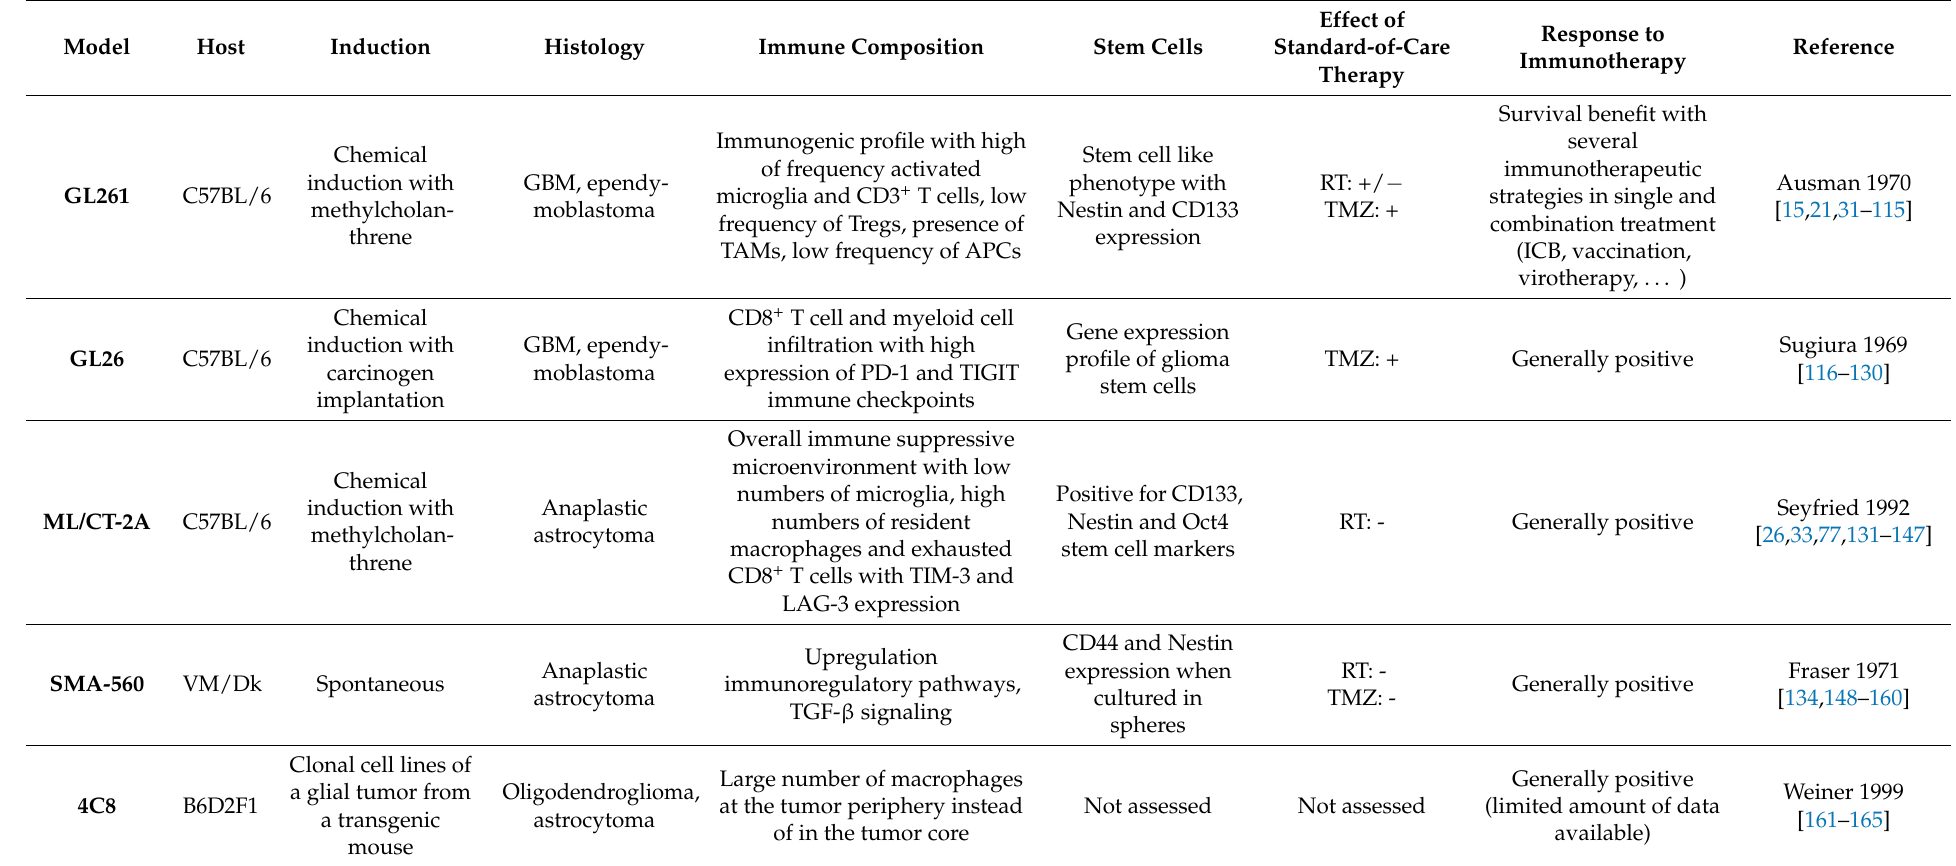
Table 1. Overview of the different characteristics of the GL26, GL261, ML/CT-2A, SMA-560 and 4C8 mouse